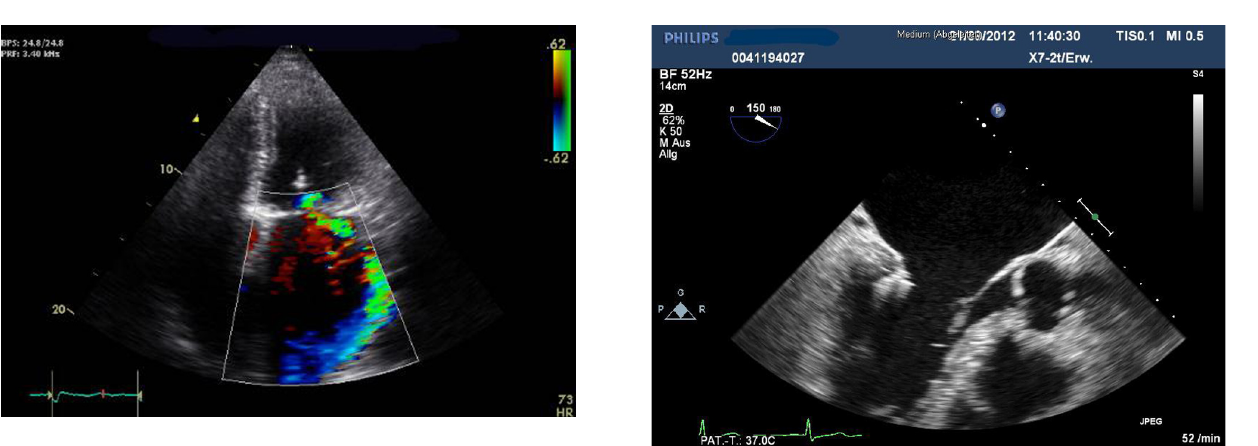
Figure 1 . Preprocedural echocardiogram with bi-atrial dilatation.